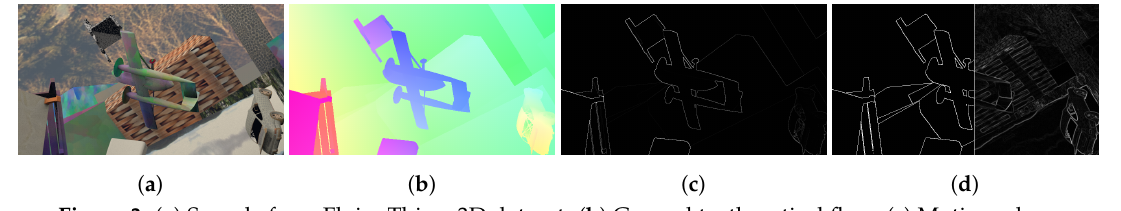
Figure 3. ( a ) Sample from FlyingThings3D dataset. ( b ) Ground truth optical flow. ( c ) Motion edges. Notice how the lion’s share of variation is concentrated on object boundaries. ( d ) Comparison of